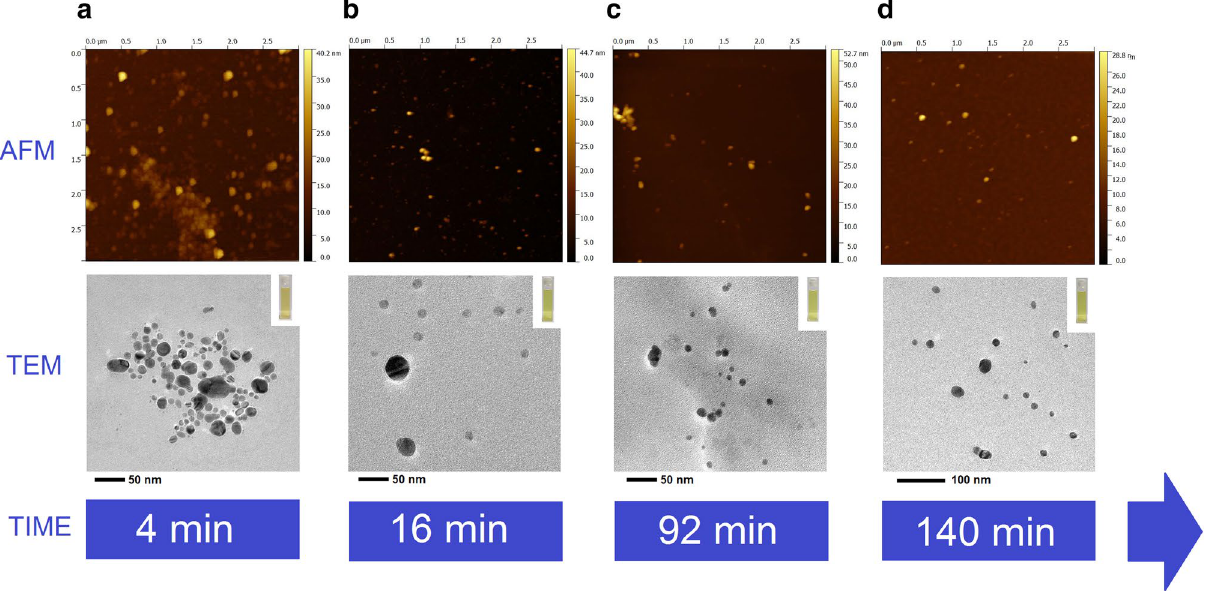
Figure 1. Monitoring the evolution of the sonochemical synthesis of AgNPs using AFM and TEM. ( a ) 4 min, ( b ) 16 min, ( c ) 92 min, ( d ) 140